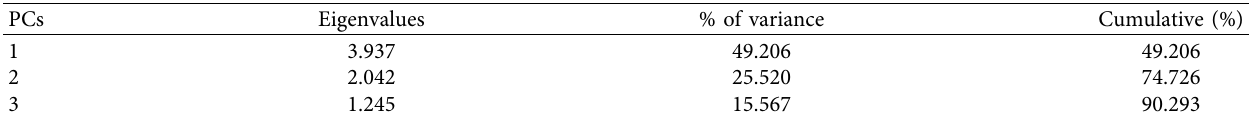
Table 6: Total variance is explained by principal component analysis.